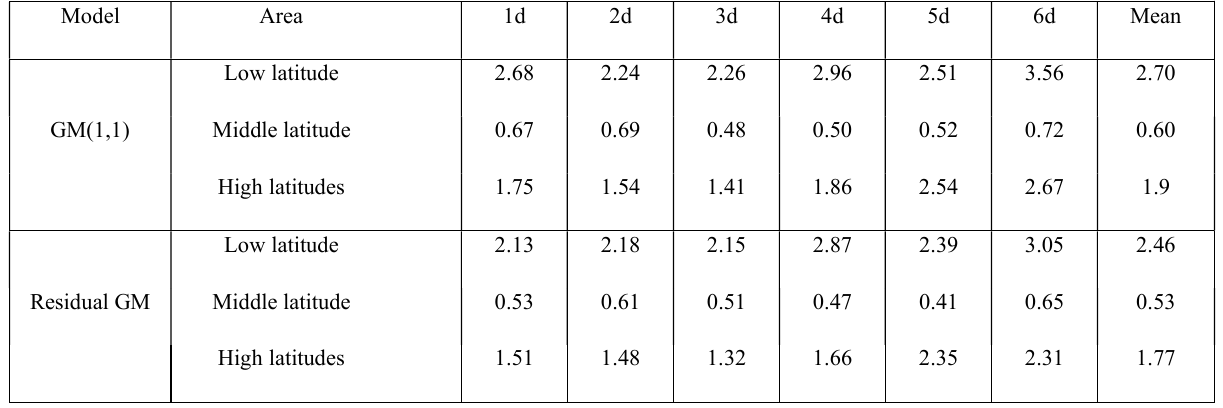
Table 4. RMSE statistics of mean-variance in spring forecast